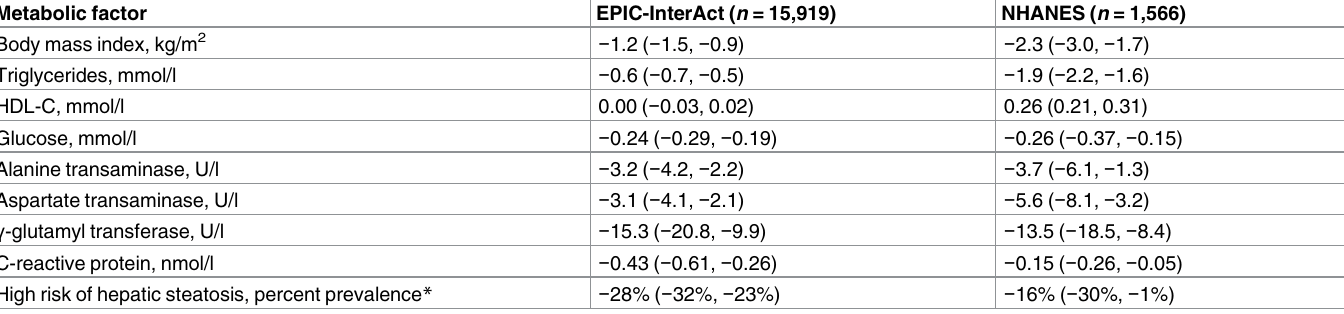
Table 3. Associations of the fatty acid pattern score with metabolic factors in EPIC-InterAct and with metabolic factors in the US NHANES 2003– 2004. Metabolic factor